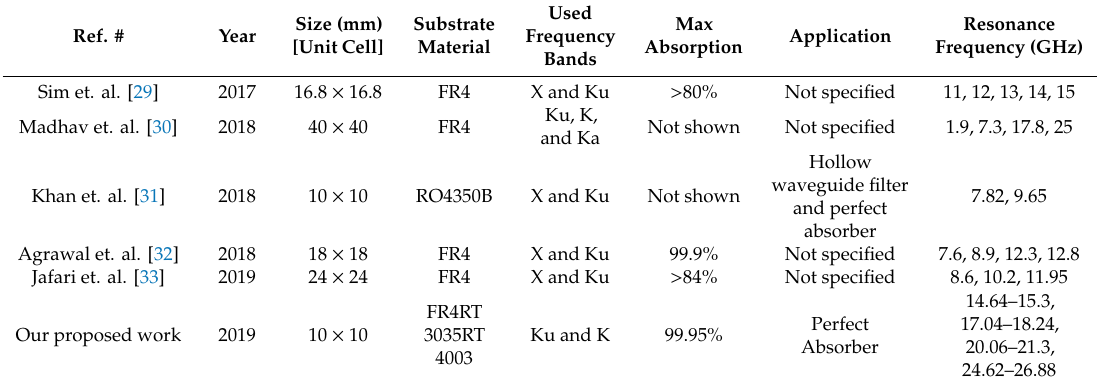
Table 6. Comparison of developed multiband metamaterial (MM) absorber with relevant other papers. Ref.